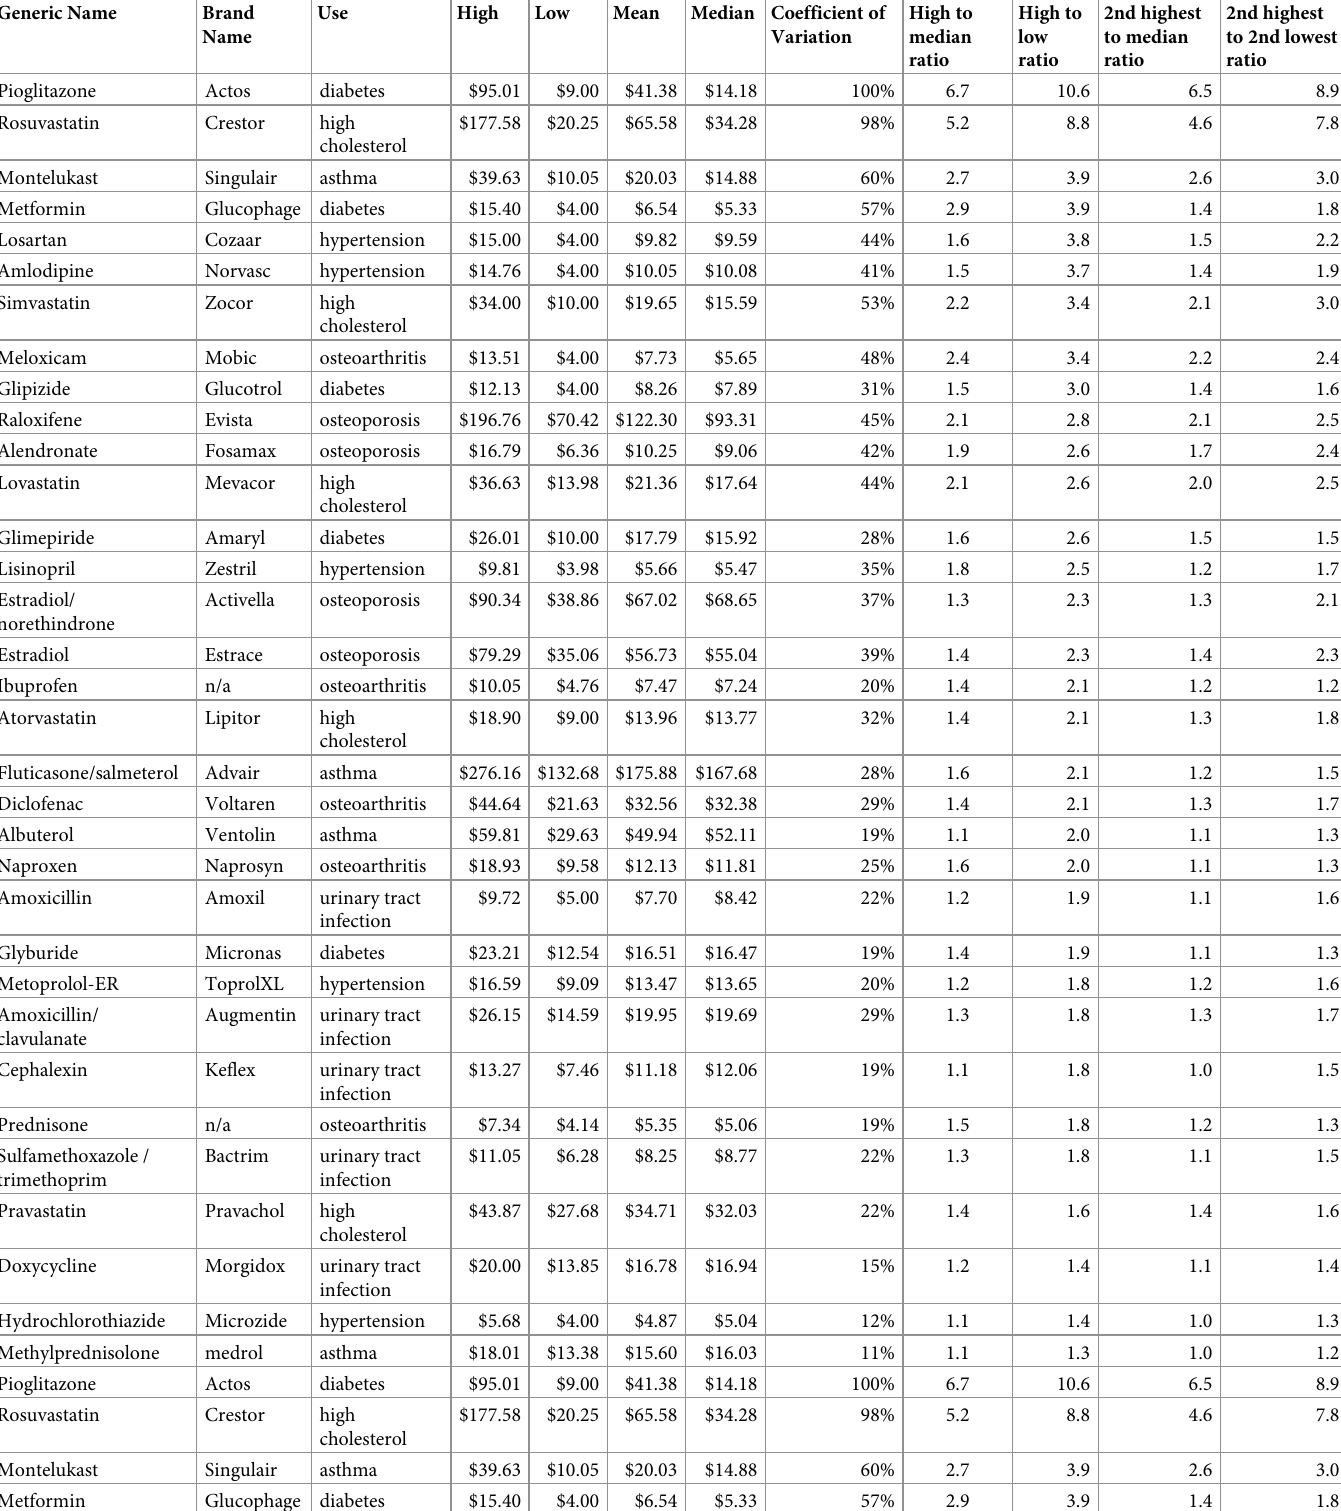
Table 2. Price dispersion parameters for control medications, ordered by high to low price